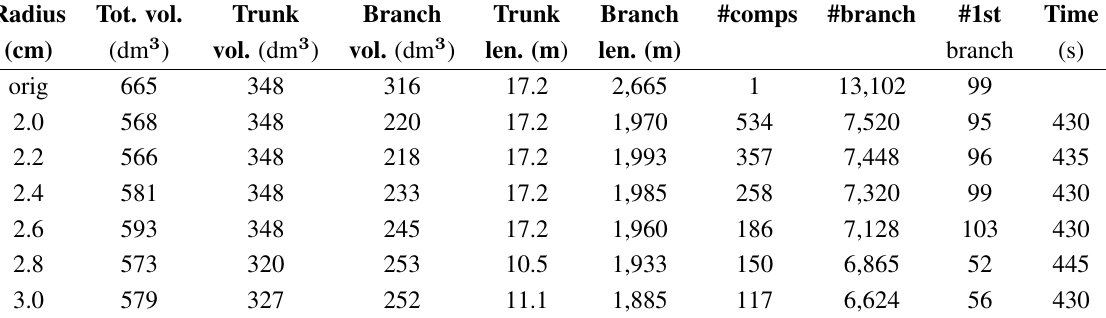
Table 1. Effects of the cover set radius. #comps, #branch, and #1st branch columns give the number of tree components, branches reconstructed with cylinders, and first-order branches, respectively. The time column gives the time for completing the model (MacBook Pro, 2.8 GHz, 8